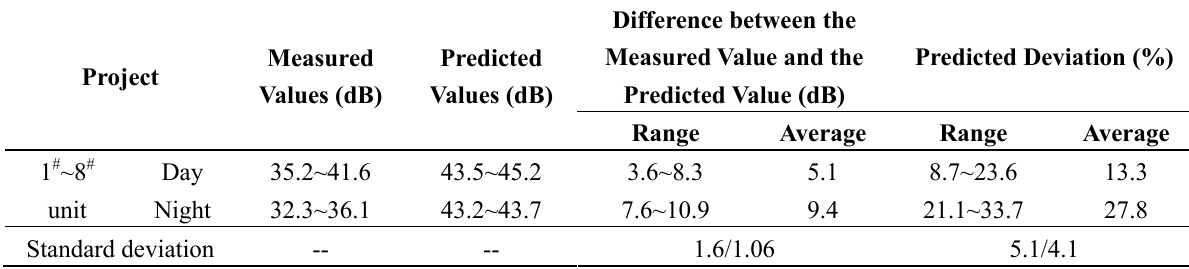
Predicted Deviation (%)